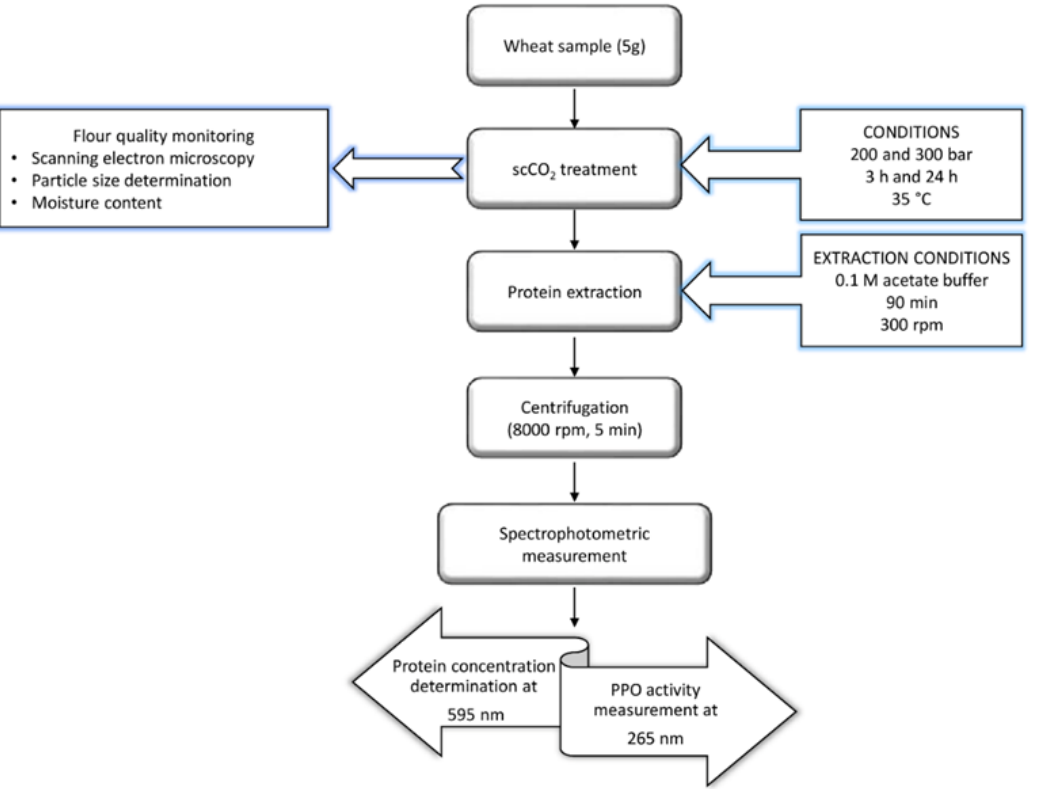
Figure 6. Flow diagram showing the procedure of graham flour analysis.